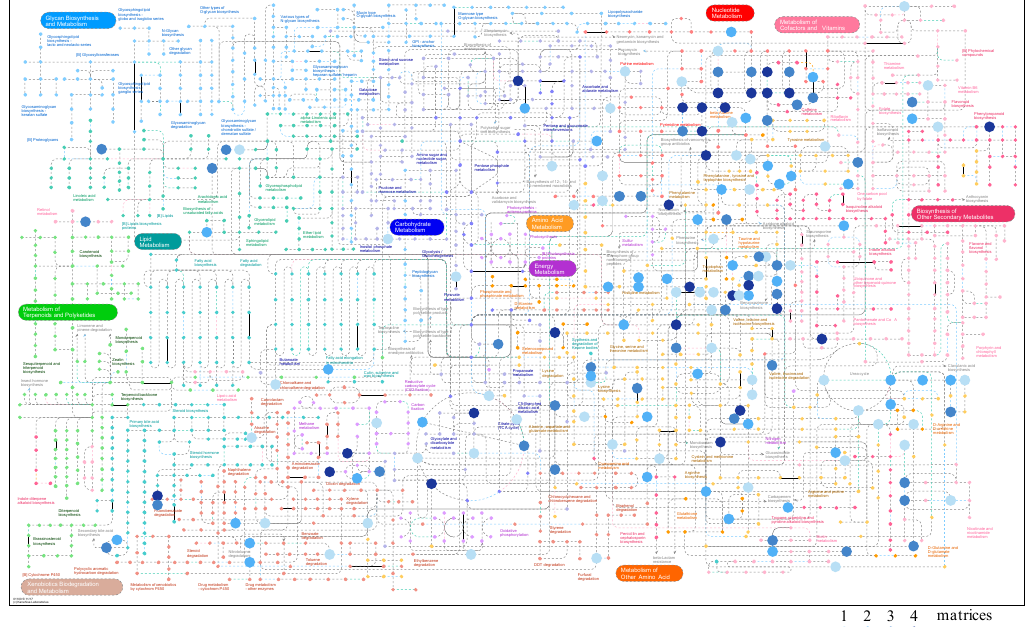
Figure 4. Metabolomic card showing metabolites from urine, blood, saliva, and feces through the metabolomics pathway to illustrate an individual. Metabolites expressed in one, two, three, or four matrices are shown in the blue gradient color.